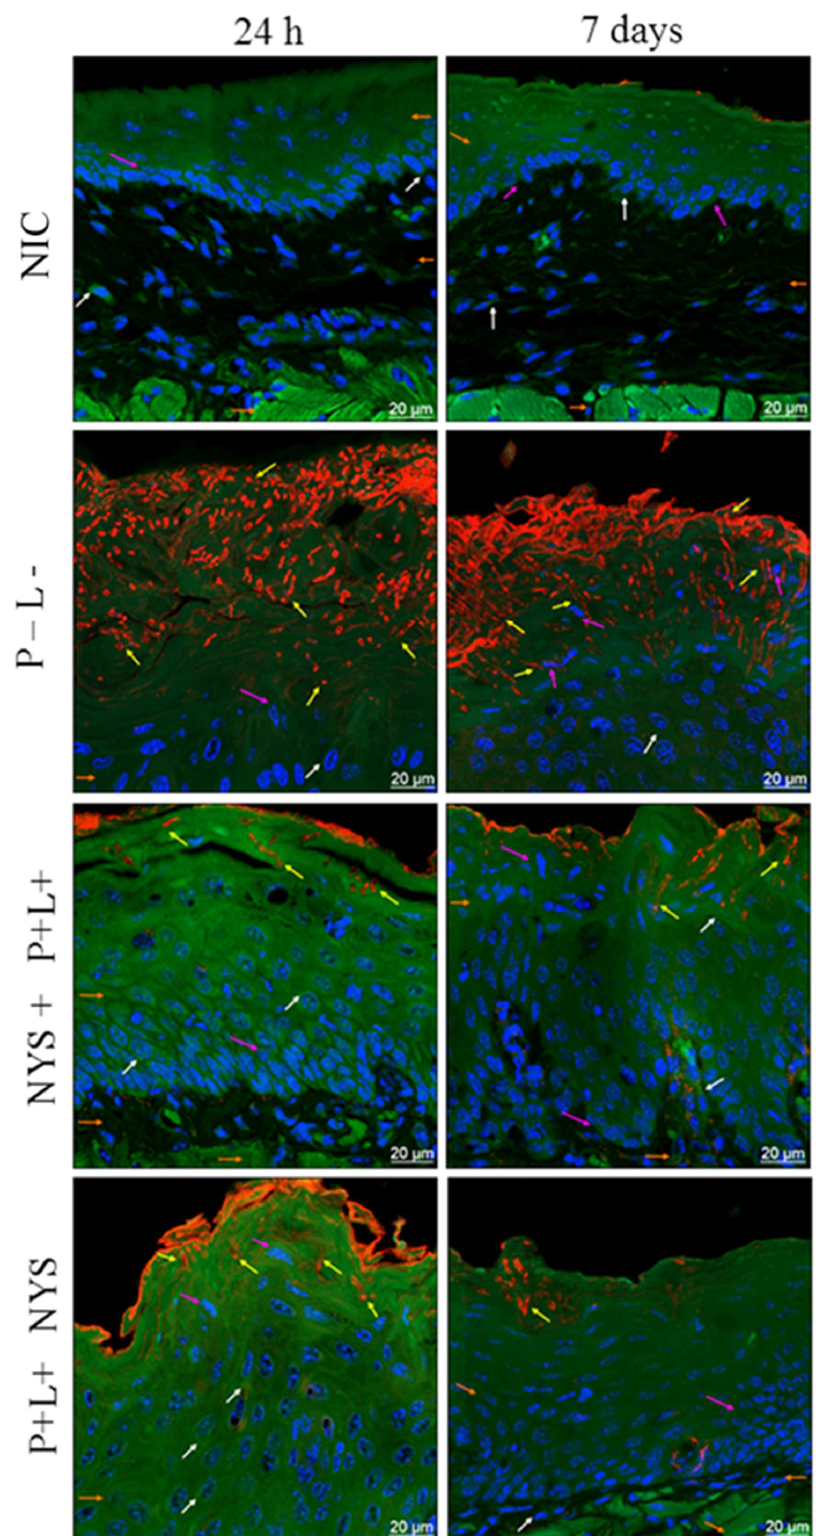
Figure 7. Representative images of the tongue tissues of mice with oral candidiasis by CLSM, showing nuclear morphology markings (pink arrows—nuclei labeled with Hoescht 33342); a microbial invasion (yellow arrows— C. albicans marked with Concanavalin 594 nm); a cytoplasmic morphology (white arrows—488 nm phalloidin-labeled cytoskeleton); an epithelial layer; connective tissue; and muscle tissue (orange arrows) for the NIC, P-L-, NYS + P + L + , and P + L + NYS + groups, after 24 h and 7 days of